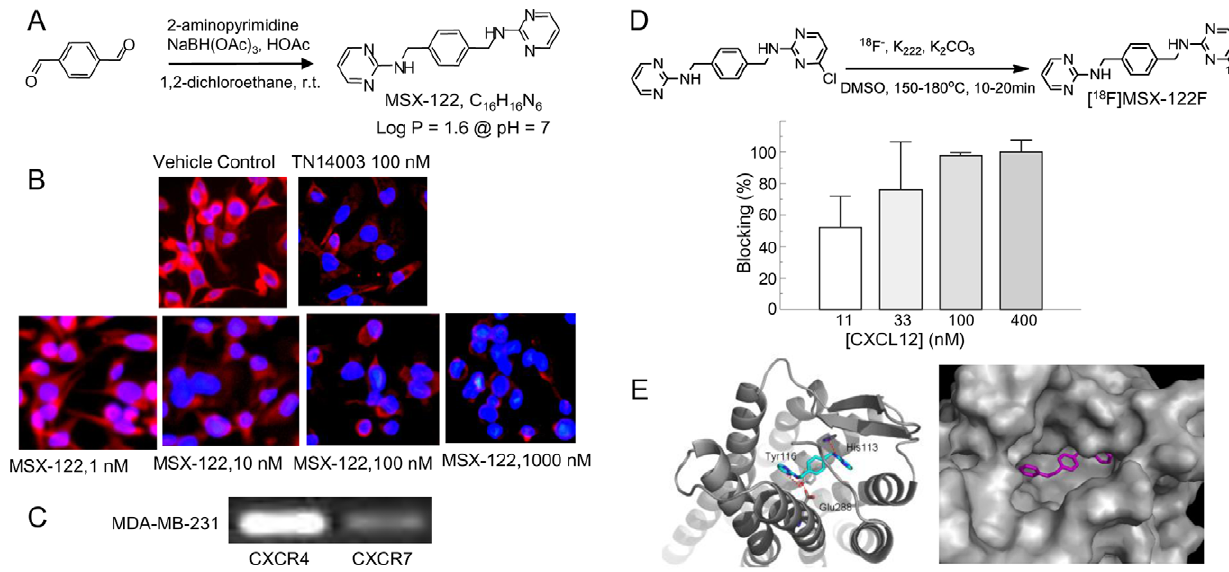
Figure 1. Synthesis of MSX-122 and invitro functional assays. (A) Scheme of MSX-122 preparation. (B) Representative immunofluorescence images show competition-binding assay using the biotinylated CXCR4 antagonist TN14003. MDA-MB-231 cells on an 8-well slide chamber were treated with TN14003 or MSX-122 at various concentrations for 15 minutes at room temperature. The cells were subsequently fixed and incubated with biotin-labeled TN14003 (0.05 m g/ml). After washing, cells were incubated with streptavidin-rhodamine. Red color represents CXCR4. Nuclei were counterstained with cytox blue. (C) RT-PCR results of CXCR4 and CXCR7 reveal that MDA-MB-231 cells do not express CXCR7. (D) Scheme of fluorine- 18 labeling of MSX-122 is shown. To determine binding of MSX-122 to a CXCL12 binding site on CXCR4, we tested whether preincubation with CXCL12 (11, 33, 100, and 400 nM) before adding [ 18 F]MSX-122F blocked binding to CXCR4 in the CXCR4-positive metastatic SCCHN cells. (E) A low energy predicted binding pose for MSX-122 (magenta) in the CXCR4 X-ray structure (grey) is illustrated by two different visualizations: ribbon (left) and protein surface (right) representations. The complex was constructed by extracting the small molecule antagonist IT1t from the X-ray structure (pdb code 3ODU; [33]) followed by docking MSX-122 into the corresponding binding